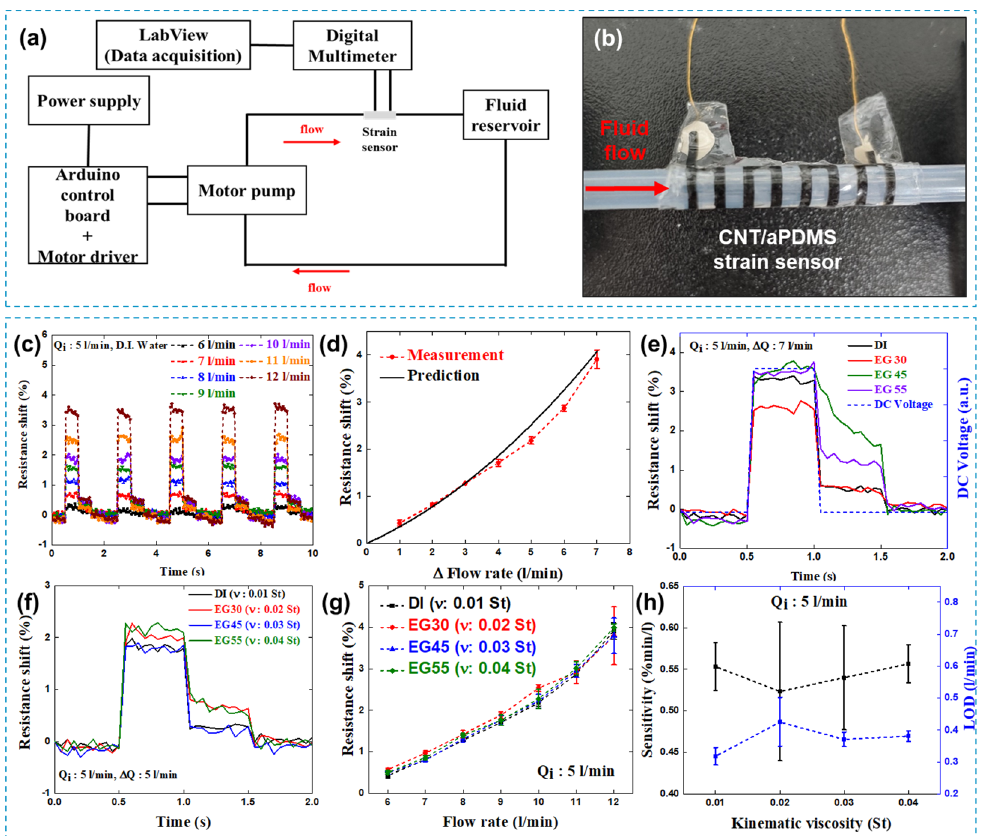
Figure 4. ( a ) Schematic of the fluid − flow measurement system consisting of a motor pump to flow the fluid, digital multimeter to measure the resistance, fluid reservoir, and tube; ( b ) photograph of aPDMS/CNT strain sensor rolled on the silicone tube with a fluid flow; ( c ) resistance shift depending on the different flow rate for five cycles of flow-rate change with DI water; ( d ) the comparison between the measured average change in resistance as a function of the change in fluid-flow rate (each point is an averaged value of 10 measurements) and the predicted change in resistance from analytical modeling; ( e ) resistance shifts and driven DC voltage depending on flow rate changes with various fluids such as deionized water, the ethylene glycol solutions with different weight concentrations; ( f , g ) resistance shift depending on fluids with different kinematic viscosities; ( h ) variations in sensitivity and LOD depending on fluid kinematic viscosity.